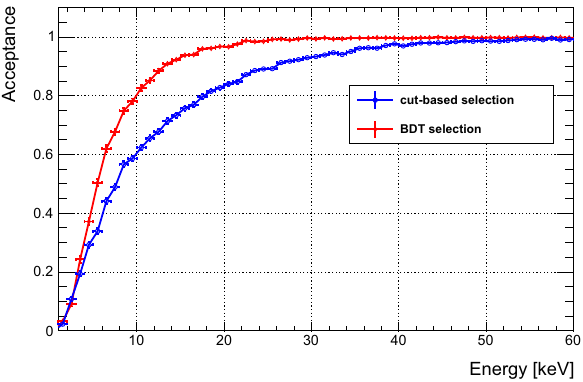
Fig. 10 Acceptance vs energy for the cut-based analysis and the mul- tivariate BDT analysis